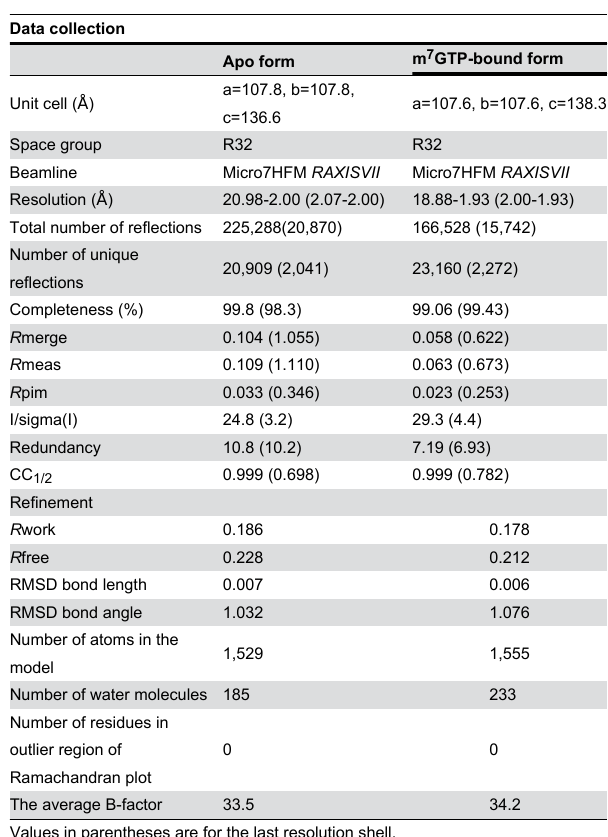
Table 1. Data collection and structure refinement statistics of PB2 middle